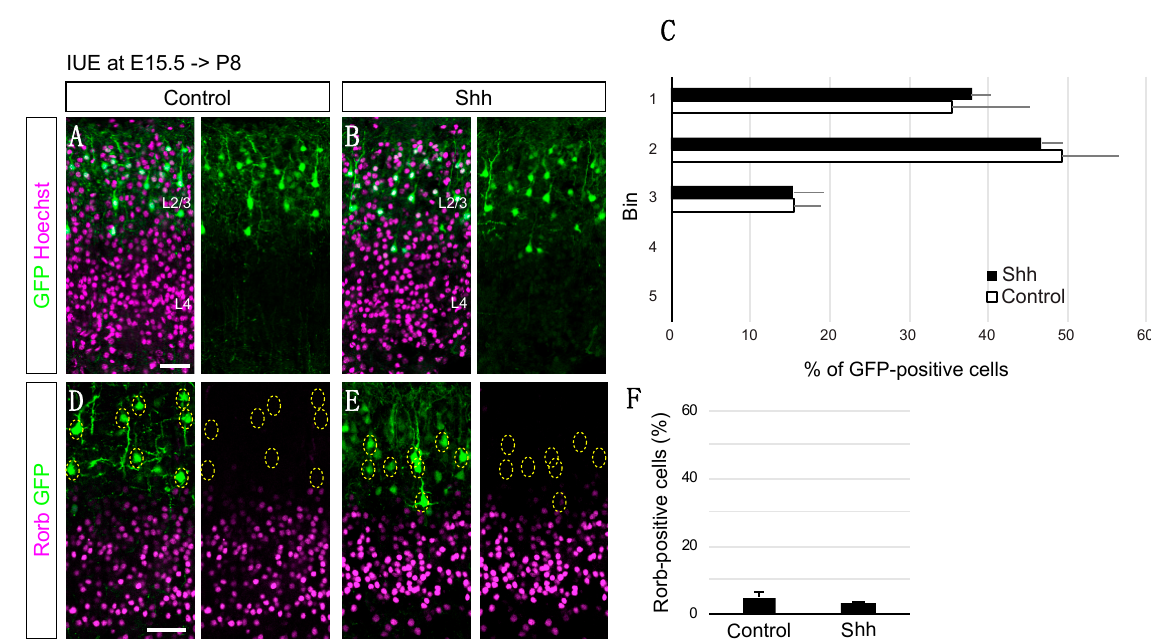
Figure 3. Shh overexpression at E15.5 does not alter cell positioning and Rorb expression. Empty (Control) or Shh expression vector (Shh) together with a GFP vector was electroporated into E15.5 brains, and then P8 brains were analyzed. The sections were counterstained with Hoechst ( A , B ) or immunostained for Rorb ( D , E ). ( C ). Quantitative data of cell positioning are presented. The position of each GFP-positive cell relative to the total distance from the bottom of L4 to the outer edge of the cortical plate was measured, followed by sorting into 5 bins (Control, n = 3; Shh, n = 4). ( F ). The result of quantitative analysis for Rorb is presented (Control, n = 3; Shh, n = 4). (Scale bars: 200 µm in ( A , D )).